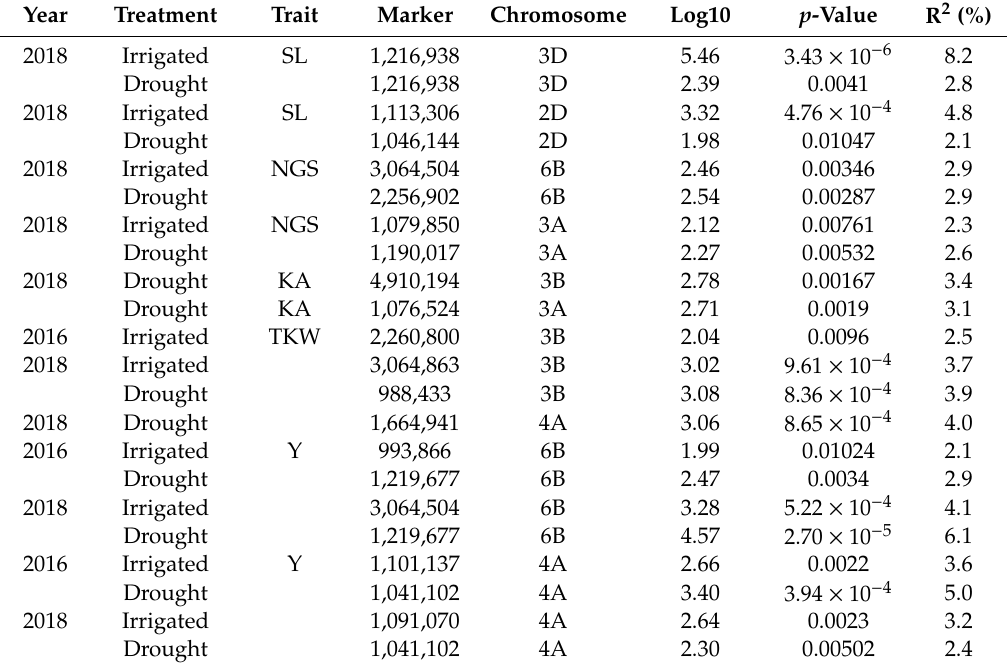
Table 2. Mix linear model (MLM) describing the location of di ff erent traits on